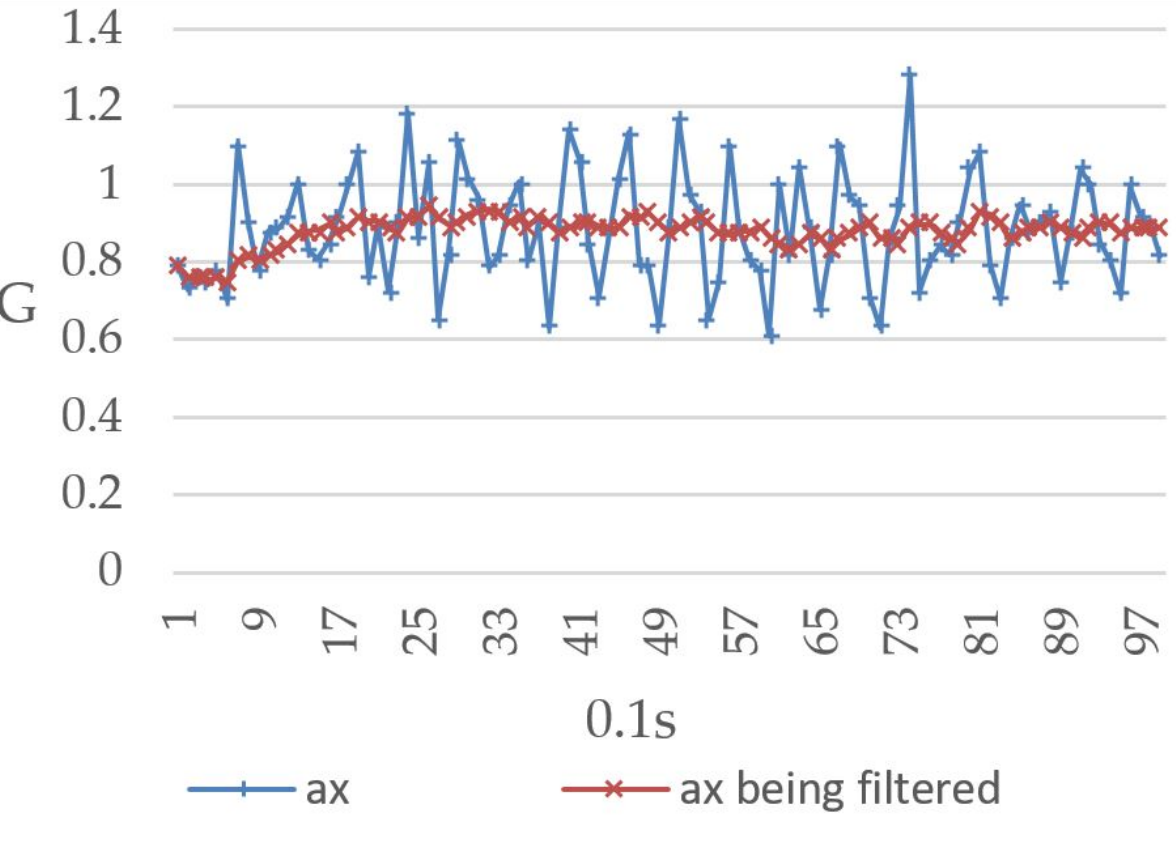
Figure 15. Triple axis accelerometer's pre-filtered x -axis values (ax) and filtered x -axis values (ax being filtered) under walking